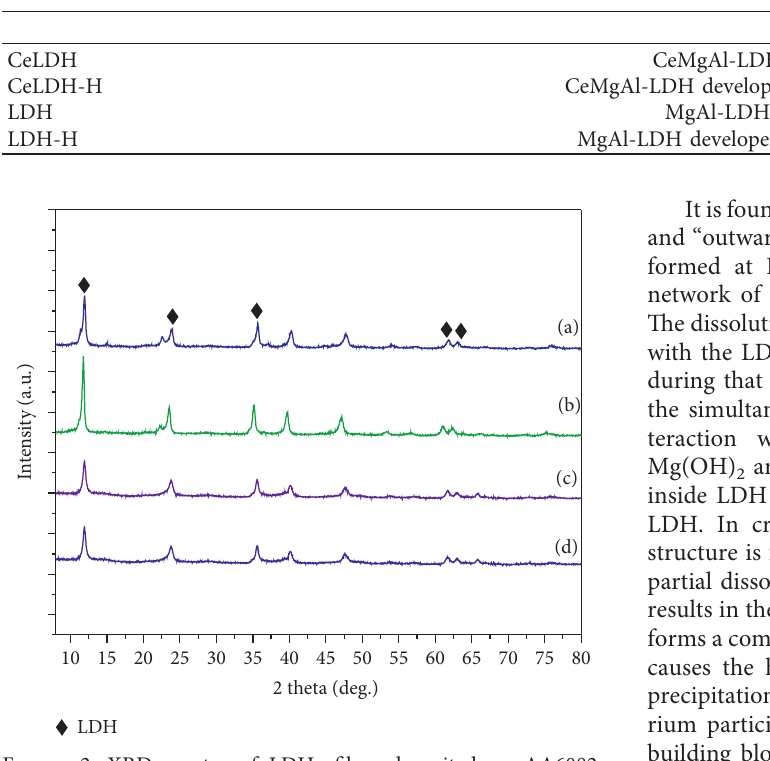
Table 1: Developed LDHs specimens.